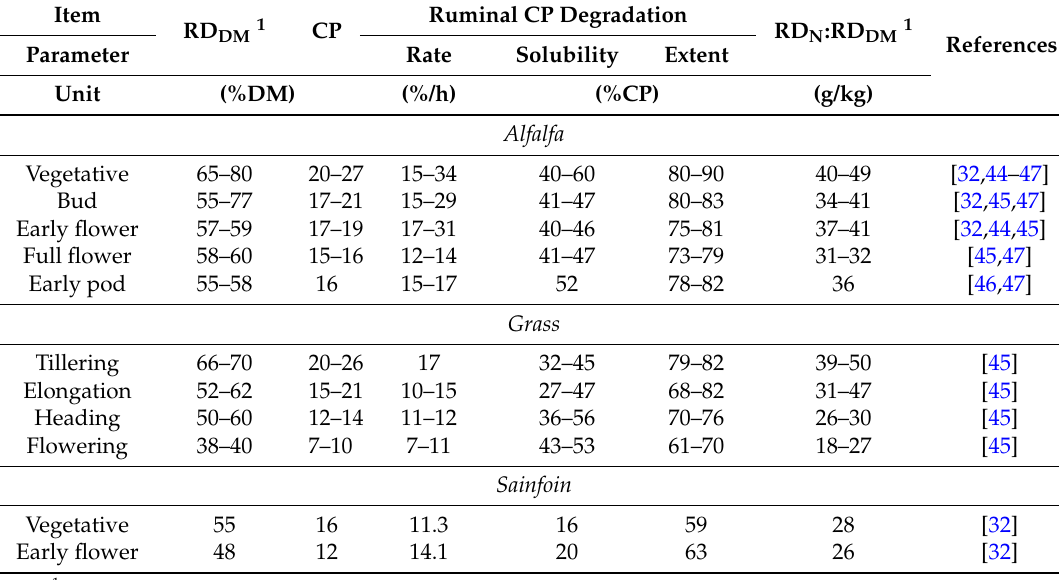
Table 2. Protein quality characteristics for freeze-dried alfalfa, grass and